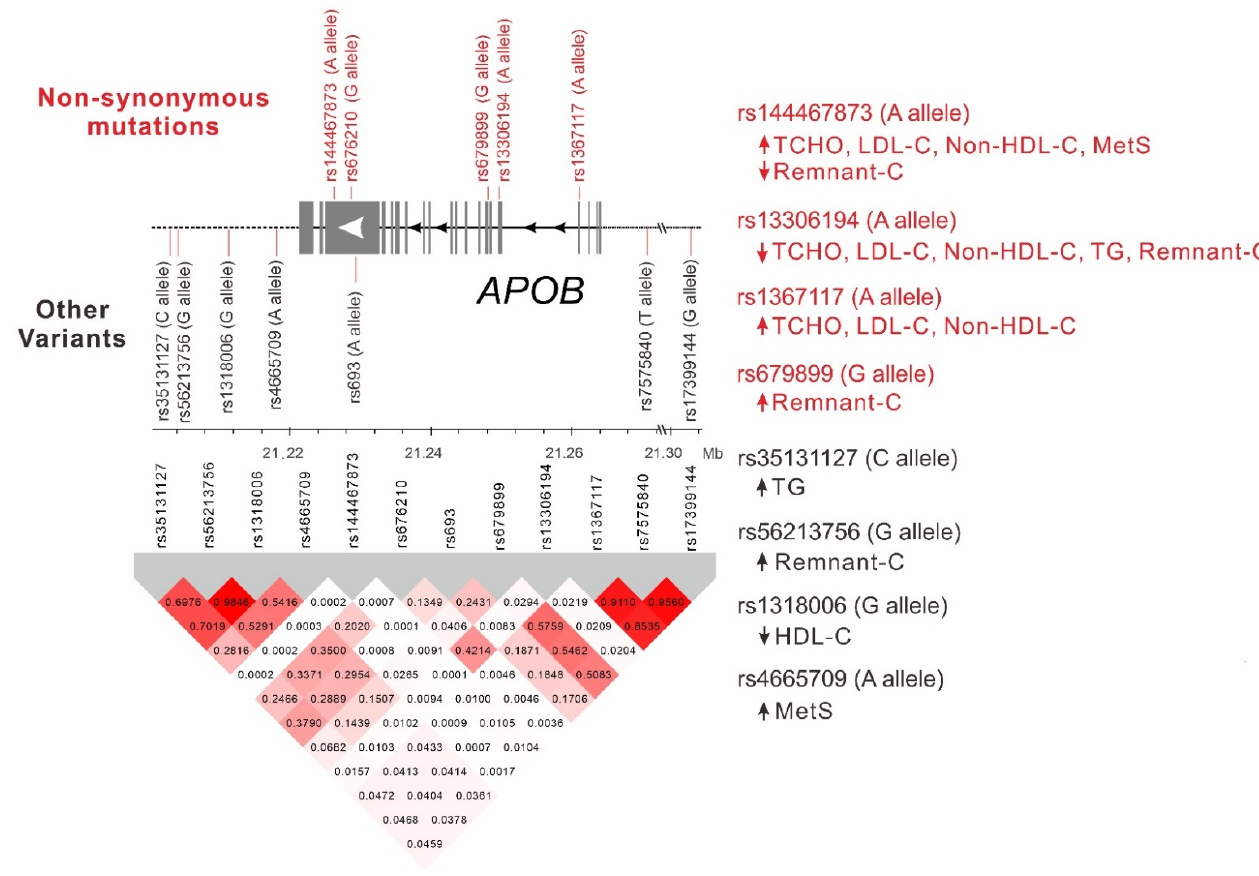
Figure 3. Linkage disequilibrium map of APOB region single-nucleotide polymorphisms ( left panel) and summary of independent associations between APOB locus variants and lipid profiles and metabolic syndrome ( right panel). The non-synonymous mutations were shown in red. Shades of red and gray show the strength of the pairwise linkage disequilibrium based on r 2 , and numbers indicate the value of r 2